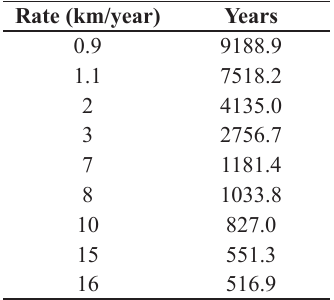
Number of years to cover the 8,270 km (5,200 mi) between USA/Mexico border and eastern South America.